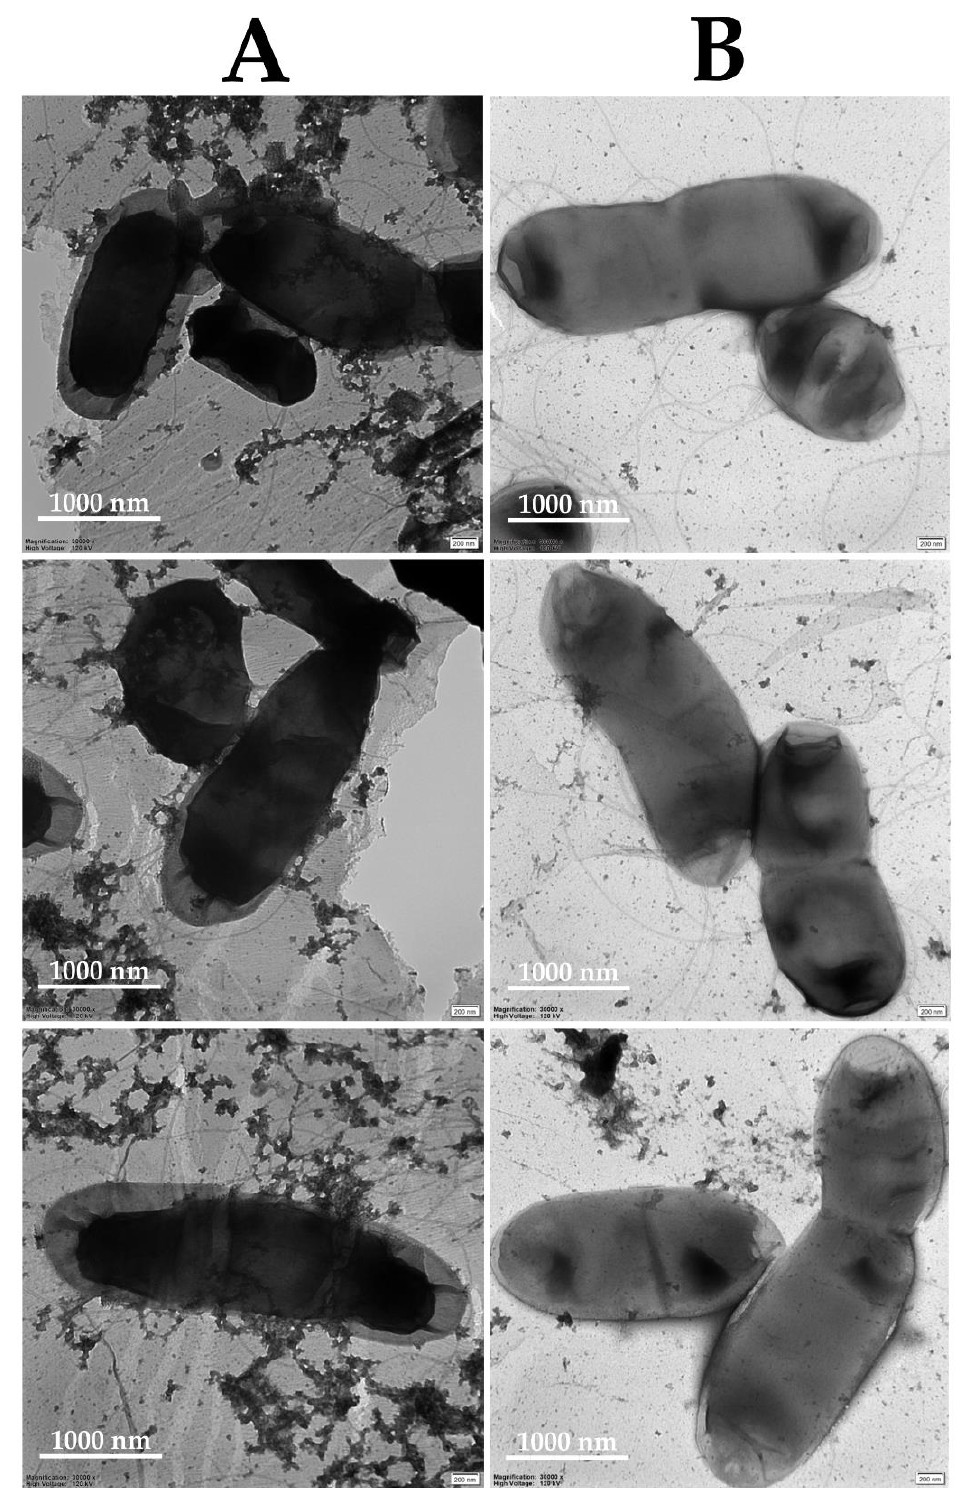
Figure 6. TEM photomicrographs of D. solani IFB0099 cells subjected to 5 min of the DBD treatment ( A ) and untreated controls ( B ). Magnification 30,000× at high voltage 120 kV.